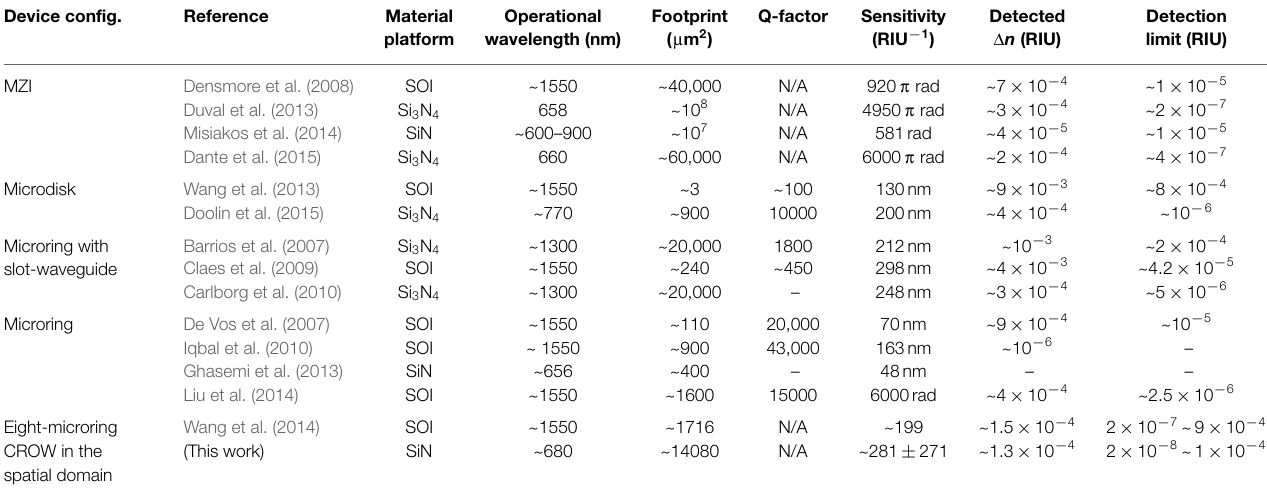
TABLE 2 | Summary of silicon- and silicon-nitride-based on-chip optical biochemical sensors . Device